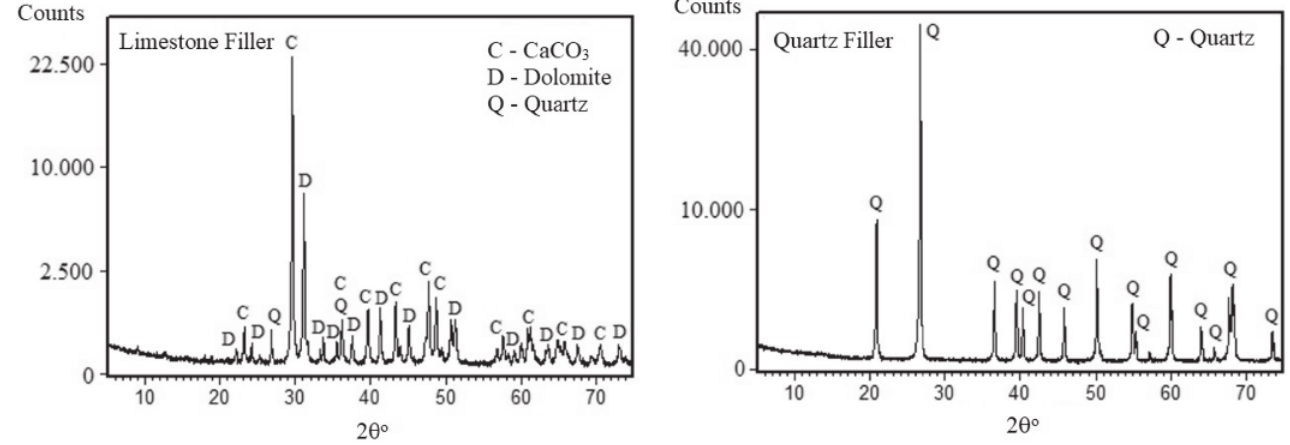
X-ray diffractograms of limestone filler and quartz